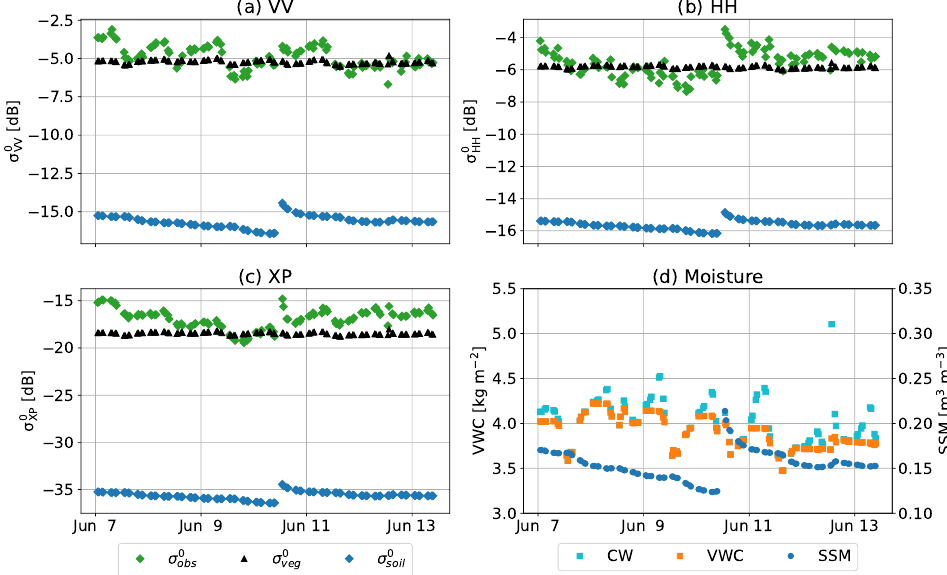
Figure 12. Six-day time series with observed backscatter ( σ 0 ), simulated σ 0 veg from the WCM, and obs simulated σ 0 from the IEM, for VV ( a ); HH ( b ); and cross-pol ( c ); moisture variations which served soil as inputs for the models are shown in ( d ); with surface soil moisture (SSM) as input for the IEM, VWC and CW, which is the VWC supplemented with dew or rainfall interception and is used as input for the WCM. Sub-daily VWC variations are based on